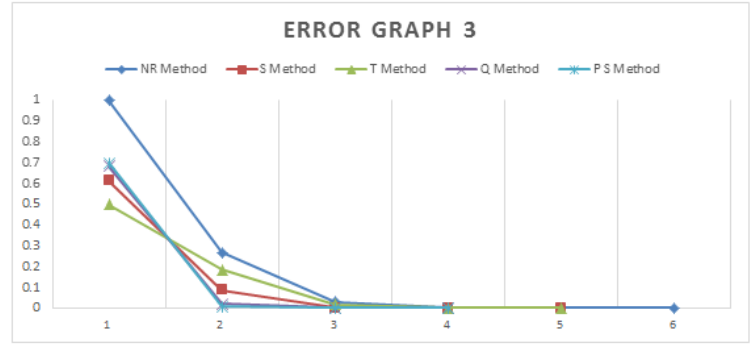
Figure 3. Graphical comparison of error analysis for the Equation (20)